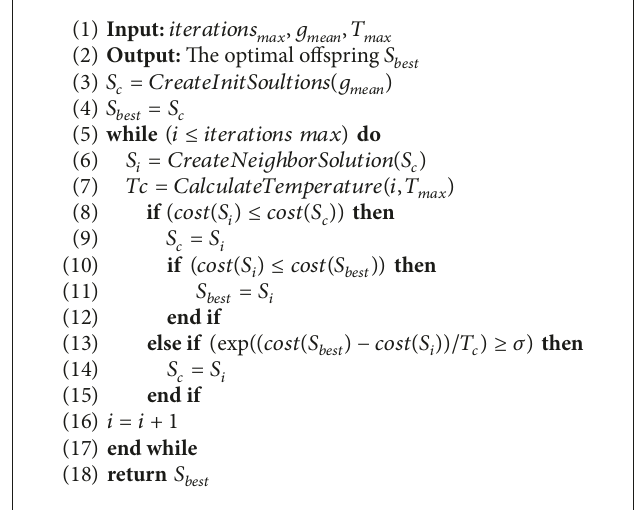
Algorithm 2: The pseudocode of the generation of offspring solutions using